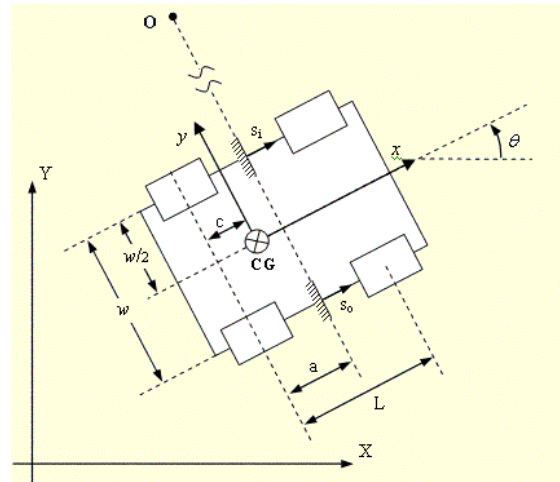
Fig. 4. Schematic of the P2AT robot.